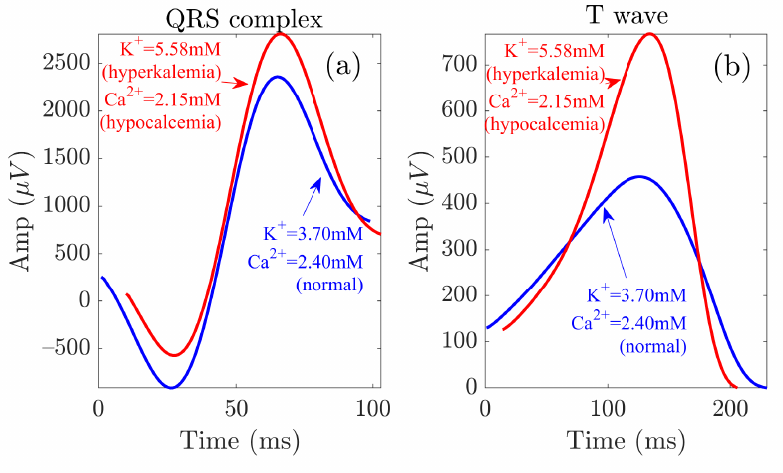
Figure 8. QRS and T wave variations at the start (red) and end (blue) of the HD session. Panels ( a , b ) show the waveforms related to the QRS complex and the T wave,